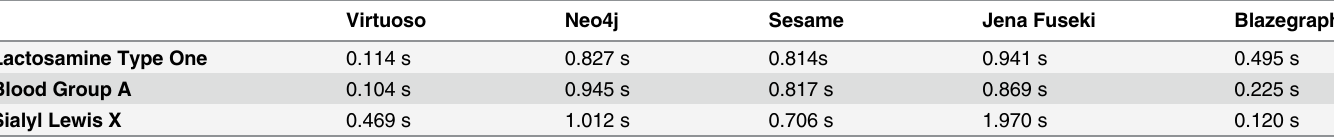
Table 1. Comparison of average response query time for 3 glycoepitopes (see Fig 5). A comparison of the average query time of Property Graph and RDF triple store databases tested in this study (columns) for three well known epitopes (rows). SPARQL and Cypher queries for these glycoepitopes are pro- vided in the S1